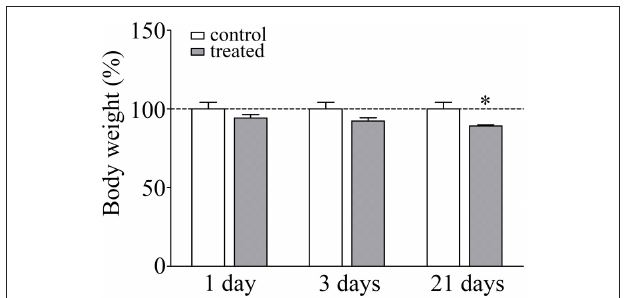
FIGURE 1 | Effect of restraint stress on the body weight of rats. Results are expressed as percentages of the unstressed control group. Values are group means ± SEM, n = 4 –5. Data were analyzed by One-way ANOVA followed by a Bonferroni post hoc test. * p < 0.05 , significant differences as compared to the control.